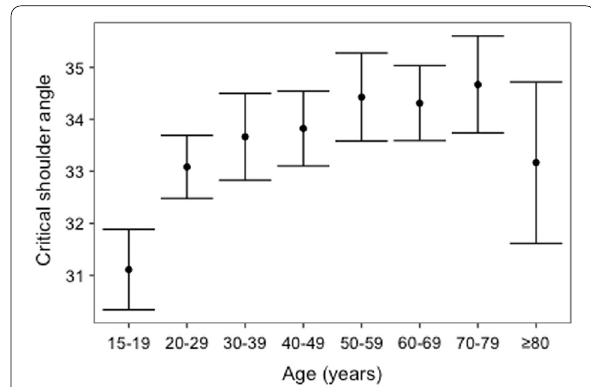
Fig. 2 CSA values according to the different age groups. Means and 95% confidence intervals by age groups